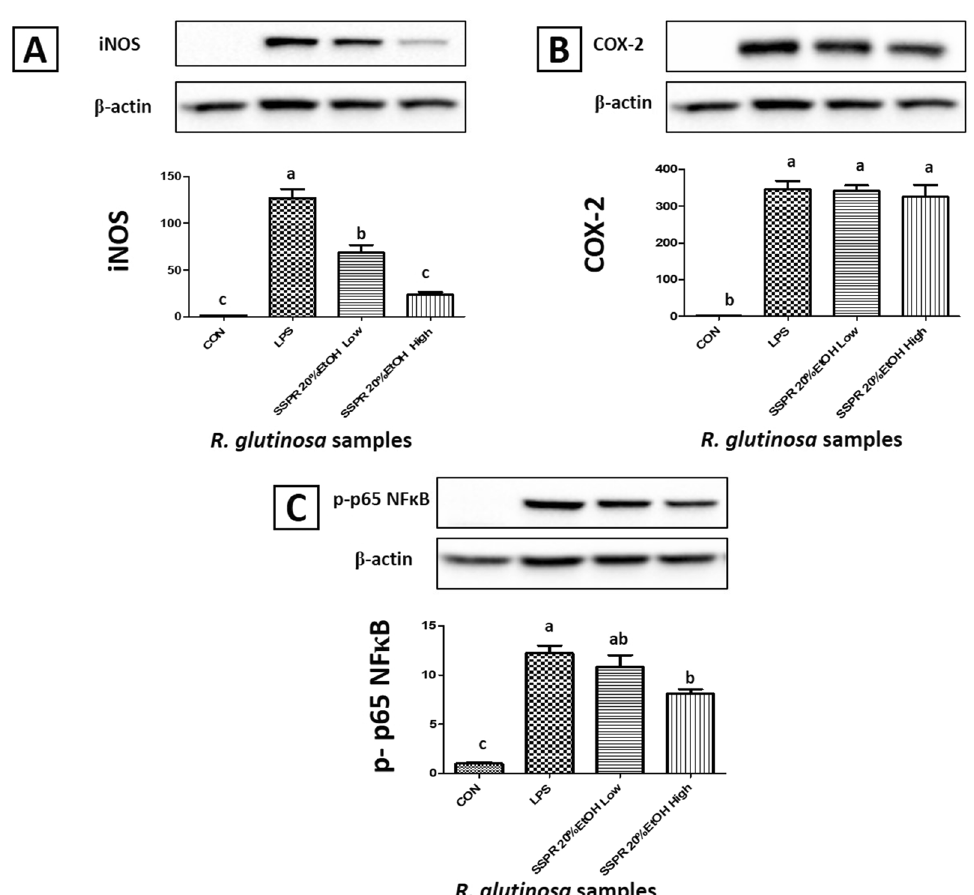
Fig. 9 Inhibition effect of processed R.glutinosa sample extracts on the expression of iNOS, COX-2, and NFκB in LPS-stimulated macrophages. a Effect of processed R.glutinosa extracts on iNOS expression. b Effect of processed R.glutinosa extracts on COX-2 expression. c Effect of processed R.glutinosa extracts on NF-κB expression. * SPRR Supplemented Processed R. glutinosa ; RW. Values are presented as means standard deviation. ± Same letters are not significantly different by Tukey’s test and p =